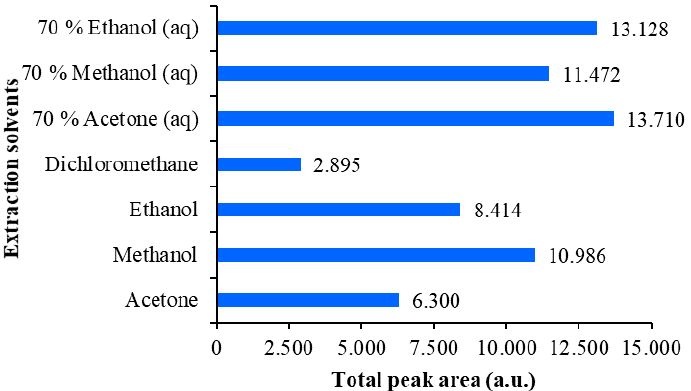
Figure 5. Comparison of the total peak areas obtained from densitograms of Japanese knotweed rhizomes STSs scanned at 442 nm on the HPTLC silica gel plate developed with toluene–acetone-formic acid (3:6:1, v / v ). STSs (2 µ L, 50 mg / mL) were prepared with 70% ethanol (aq) , ethanol, 70% methanol (aq) , methanol, 70% acetone (aq) , acetone and